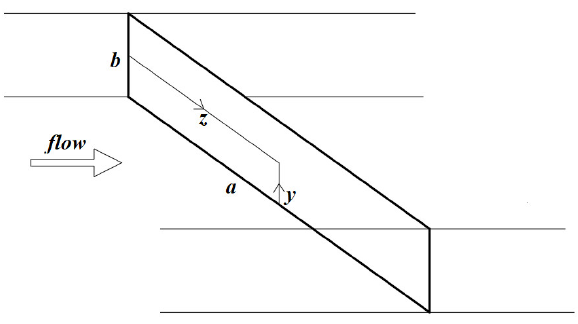
Figure 14. The middle cross section of the channel in the X direction, and the centerlines in the Z and Y directions on it.